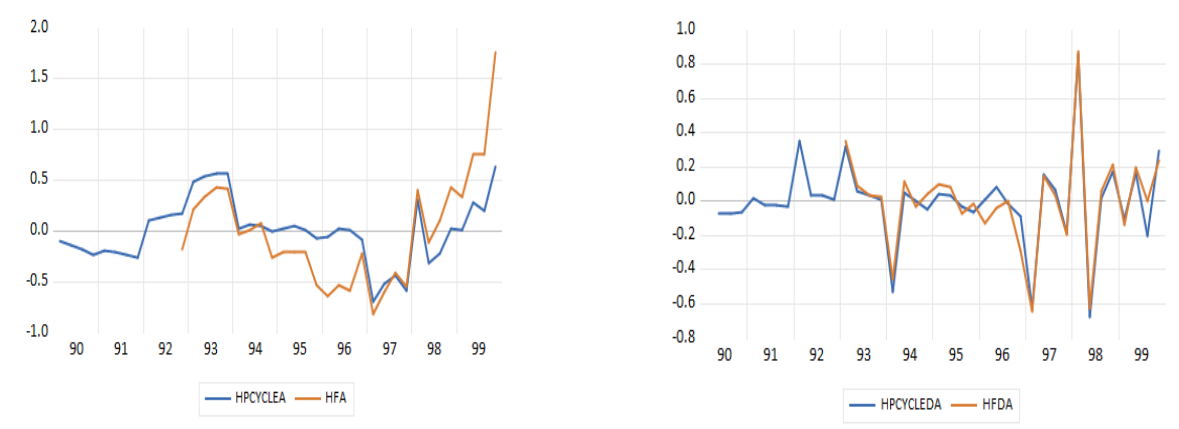
Figure 2. HP (1600) filter (blue) versus two-year regression filter HF (brown), first period.